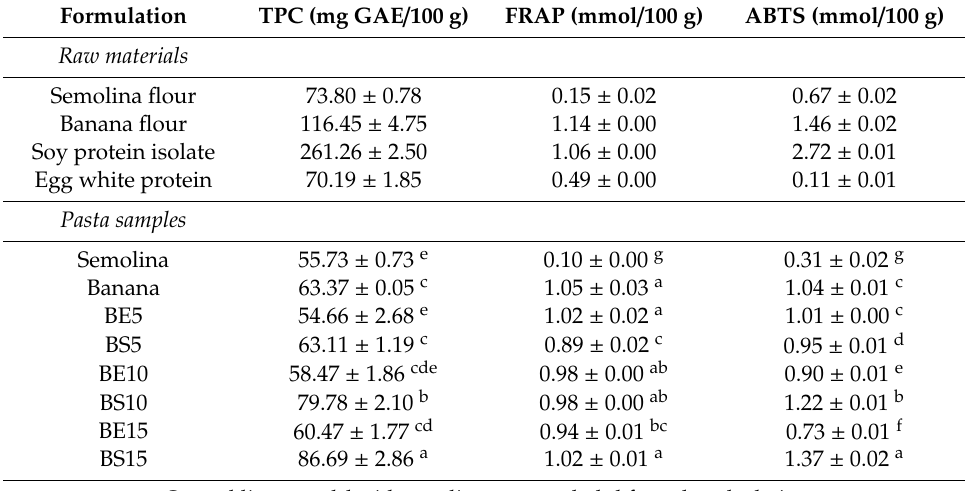
Table 1. Total phenolic content and antioxidant